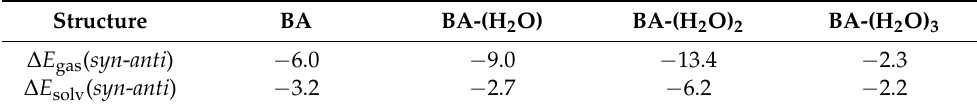
Table 1. Relative stability differences between the microsolvated syn - and anti -conformer of BA in the gas phase ( ∆ E gas ) and in the implicit solvent ( ∆ E solv ). Structures were optimized with B3LYP/def2- TZVP/D3. Relative electronic energy differences are given in kcal/mol.